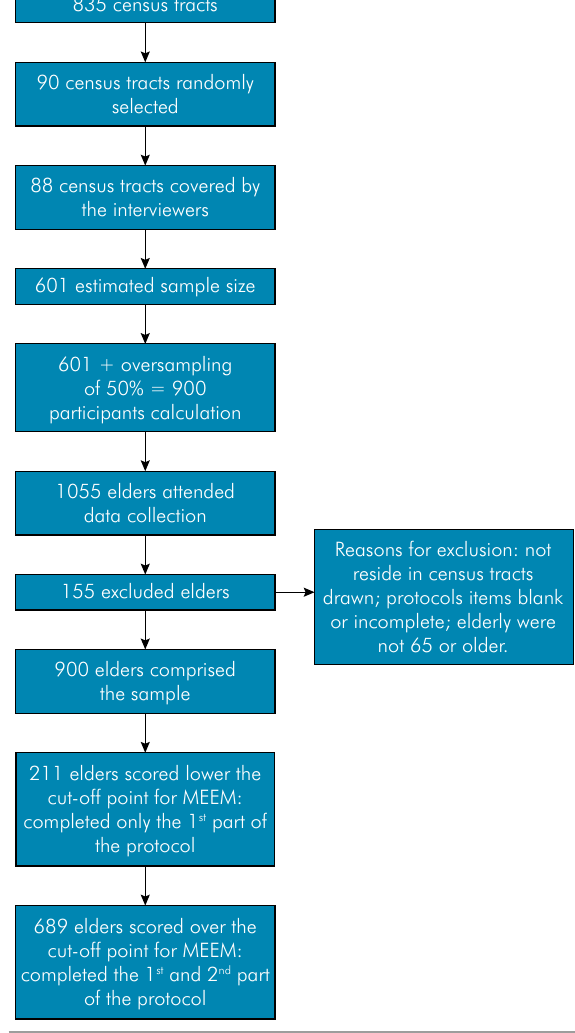
Figure. Flowchart of the sampling